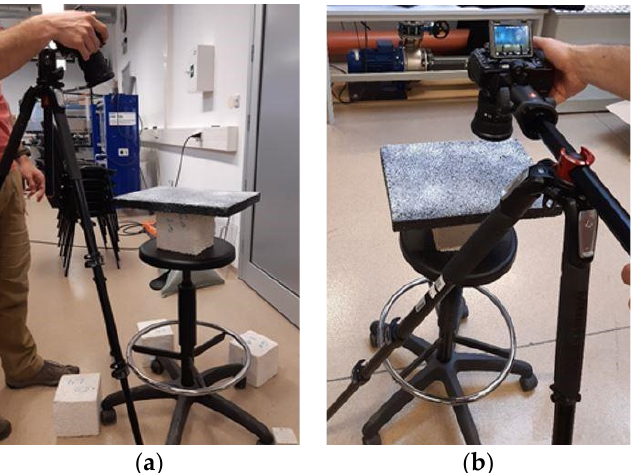
Figure 3. Image acquisition methods: structure from motion ( a ) and orthographic photogrammetry ( b